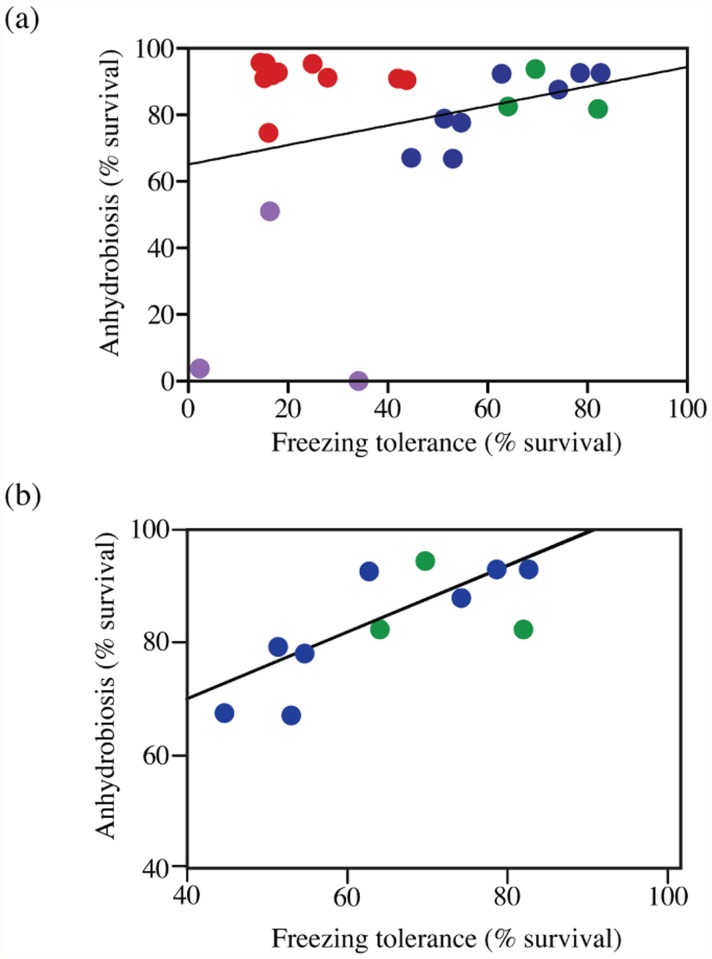
Correlation between freezing-tolerance and anhydrobiosis in Panagrolaimus.(a) Spearman rank correlation between freezing-tolerance and anhydrobiosis in all 24 Panagrolaimus strains (r = 0.0033, N.S.). (b) Spearman rank correlation between freezing-tolerance and anhydrobiosis in Panagrolaimus PCA Group 3 and Group 4 strains (Spearman’s r = 0.718, p < 0.05). The data points are shaded as follows: PCA Group 1, purple; Group 2, red; Group 3 blue; Group 4 green.